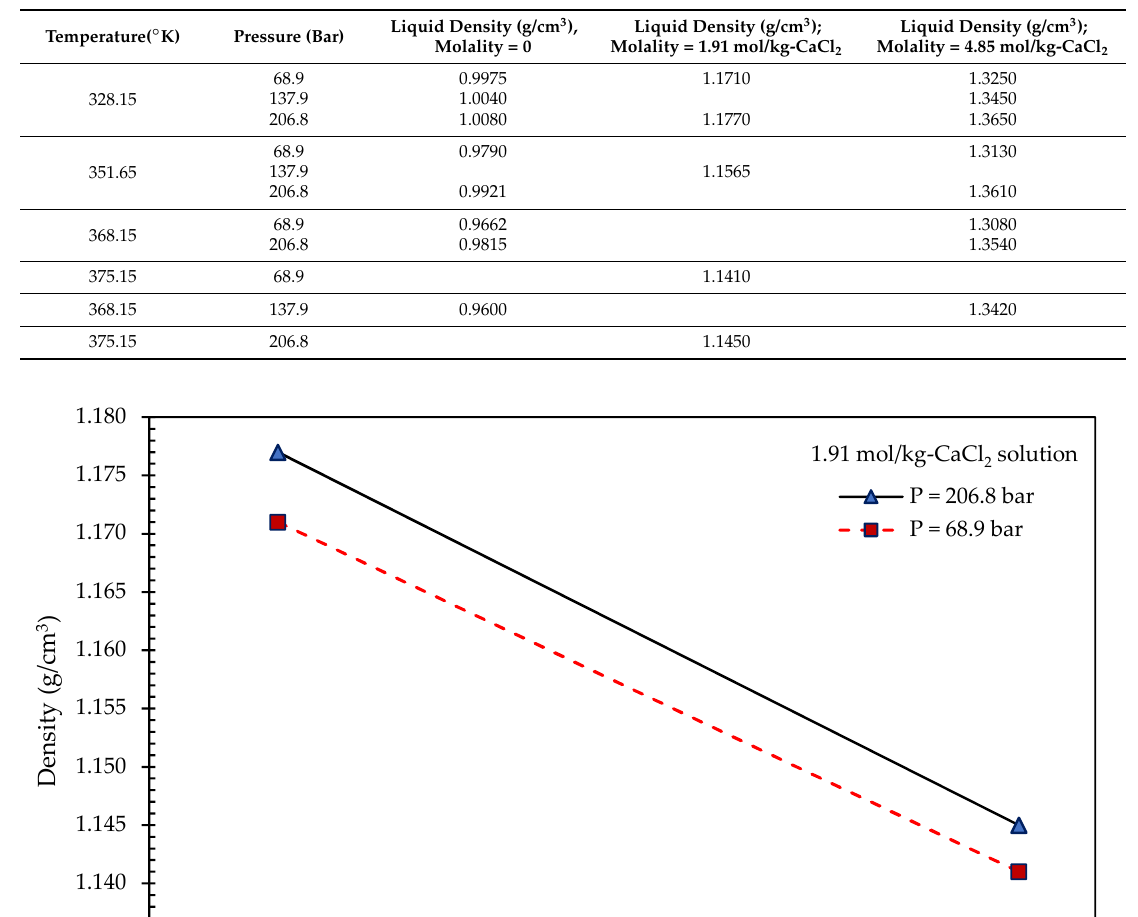
Table 2. Results from measurement of density of pure H 2 O saturated with CO 2 in P-T conditions of